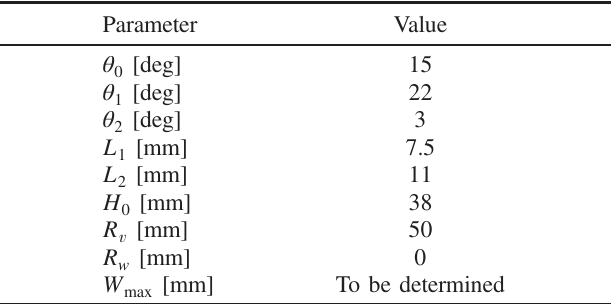
TABLE II. Cross-section parameters of the HIAF